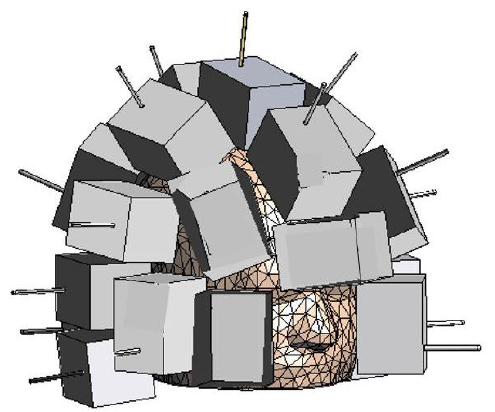
Figure 1. CAD model of the 3D MWI system together with the head